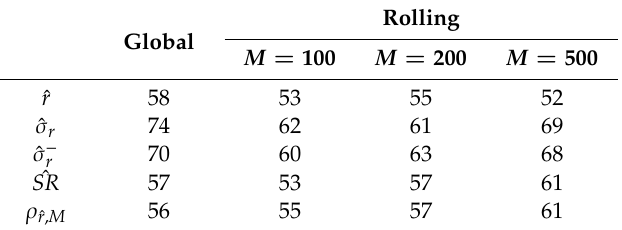
Table 2. Percentages of cases where the LQ estimates are better than the corresponding LS